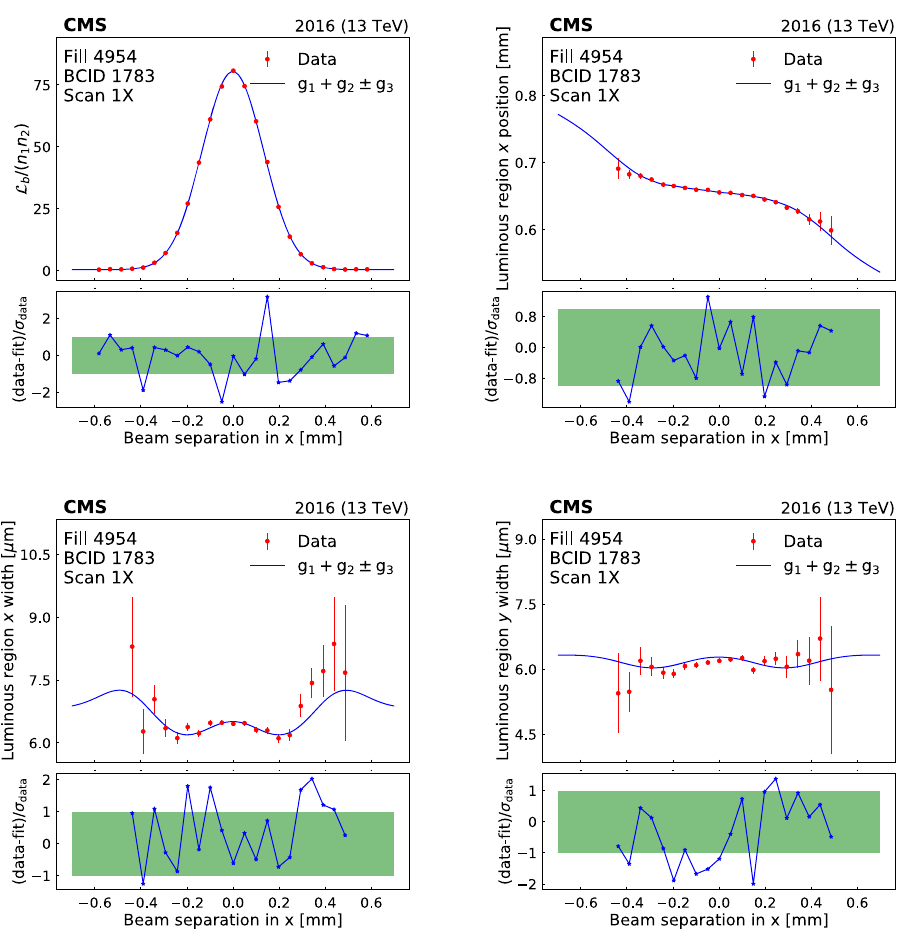
Fig. 13 Beam-separation dependence of the luminosity and some luminous region parameters during the first horizontal vdM scan in fill 4954. The points represent the luminosity normalized by the beam current product (upper left), the horizontal position of the luminous centroid (upper right), and the horizontal and vertical luminous region widths (lower left and right). The error bars represent the statistical uncertainty in the luminosity, and the fit uncertainty in the luminous region parameters. The line is the result of the three-Gaussian ( g 1 + g 2 ± g 3 ) fit described in the text. In all cases, the lower panels show the one-dimensional